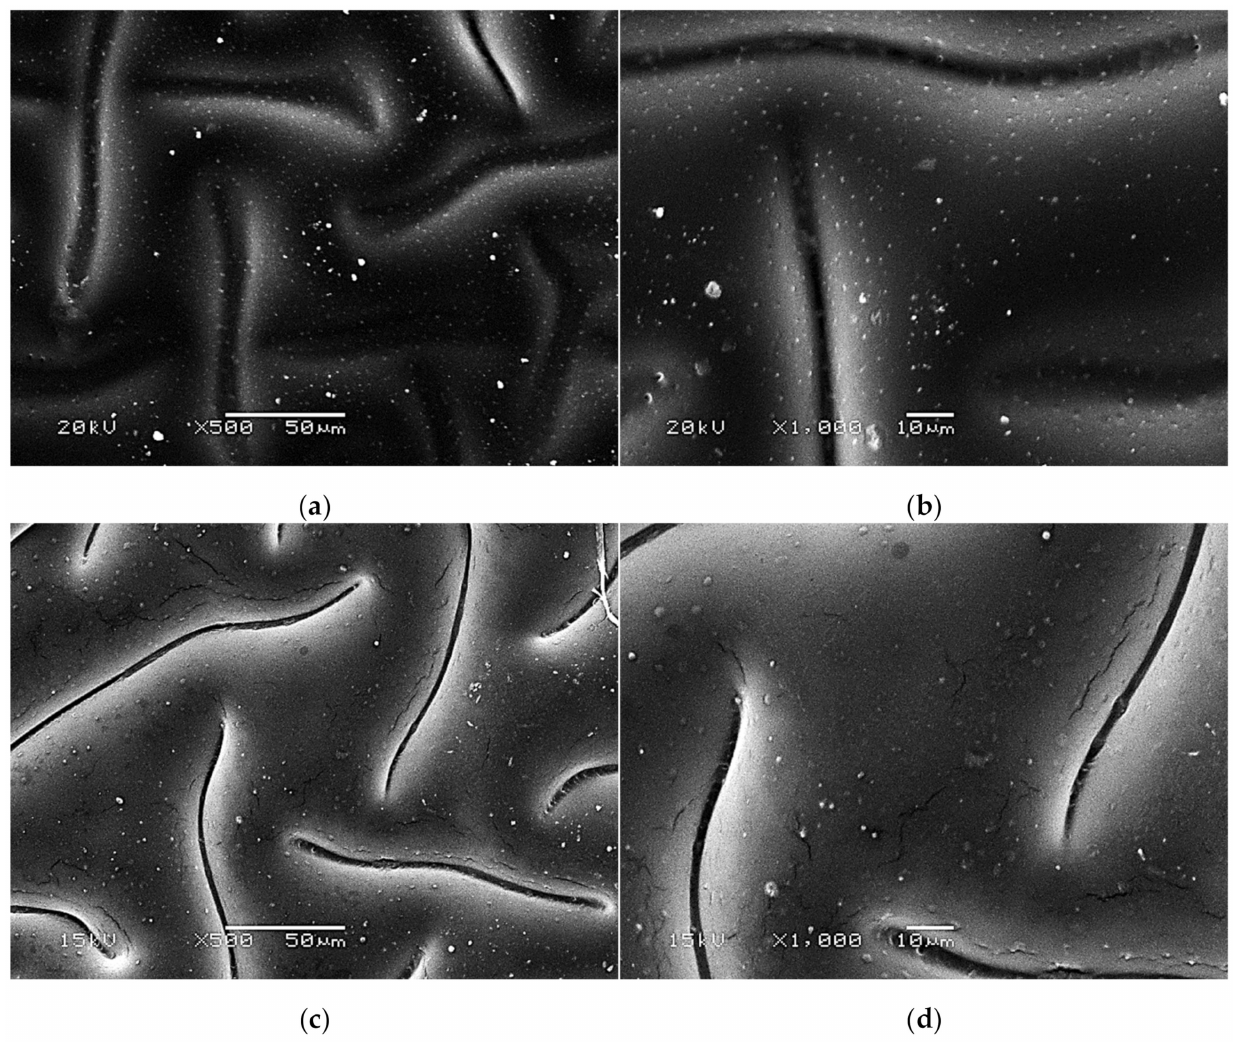
Figure 8. SEM images of modified hydrogels at various magnifications: sample 2.5/4.0 ( × 500) ( a ); sample 2.5/4.0 ( ×